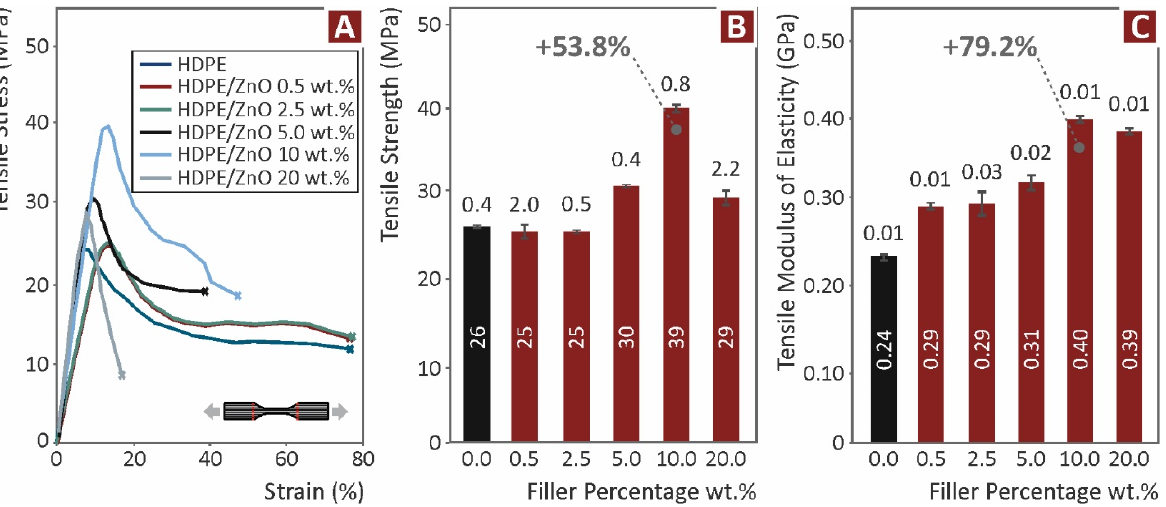
Figure 2. ( A ) Tensile stress compared to strain curves experimentally determined for the unfilled HDPE and the HDPE/ZnO composites, ( B ) Comparative average tensile strength graph (average value is depicted inside the bars) and deviation (value is depicted on top of the bars), and ( C ) Average experimentally calculated tensile mod. of elasticity values and their deviation for the materials of this work.